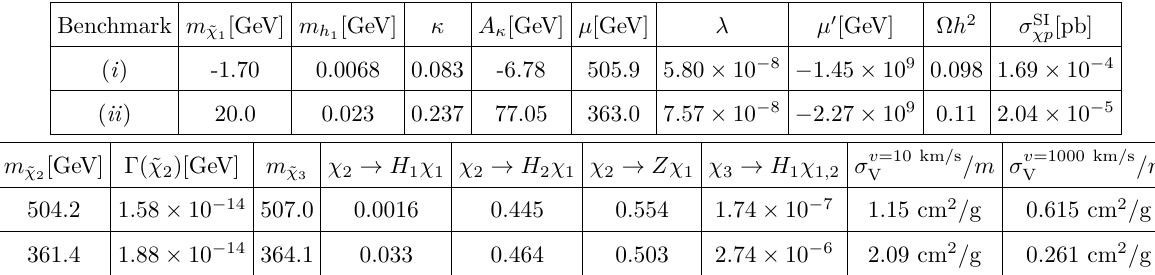
points are ∼ 400 − 1000 GeV and the corresponding production cross sections [55, 56] are ∼ 88 . 7 − 0 . 969 fb (summed cross sections of